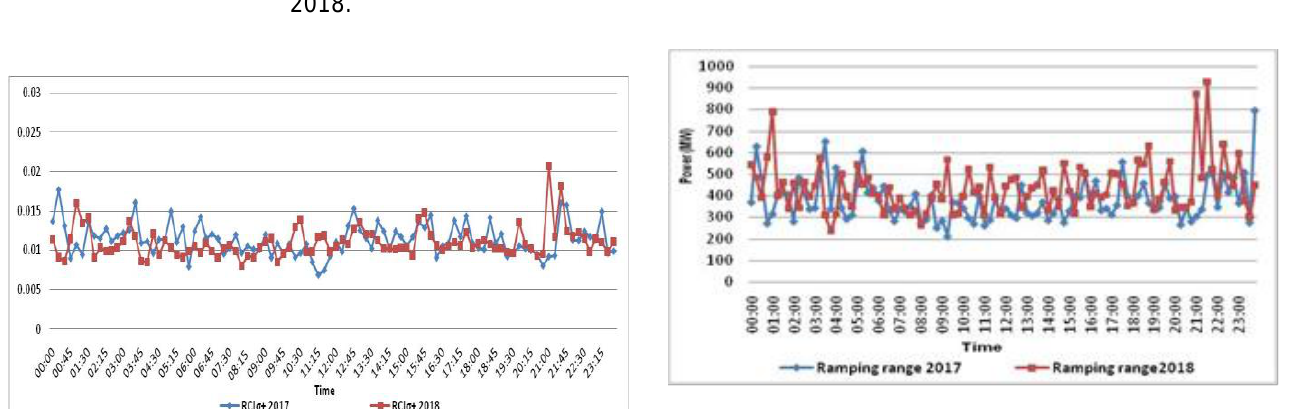
Figure 14. Comparison between RCIs for the standard Figure 17. Comparison between maximum values of deviation of downward power ramps in 15 min interval downward power ramps in 15 min interval at each at each observation time t for the years 2017 and observation time t for the years 2017 and 2018. 2018.